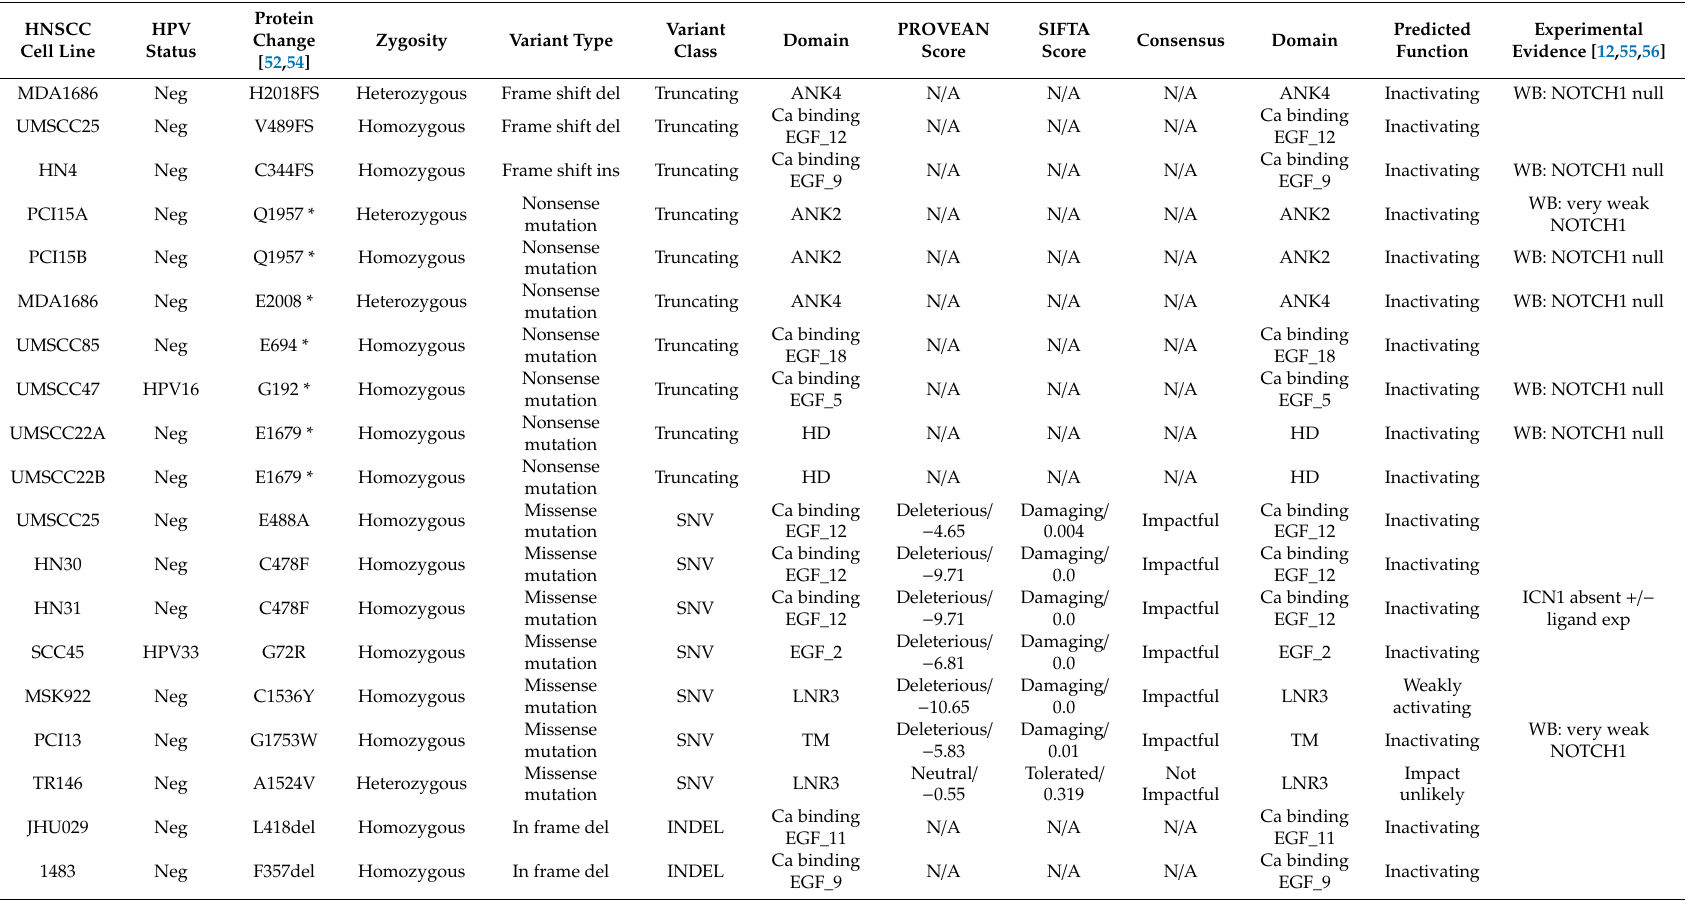
Table 2. NOTCH1 mutations in HNSCC cell